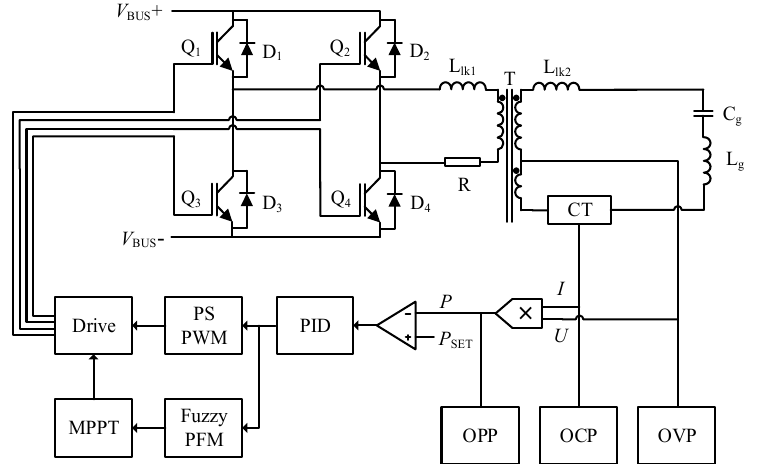
Figure 4. System mixed modulation closed-loop control diagram.